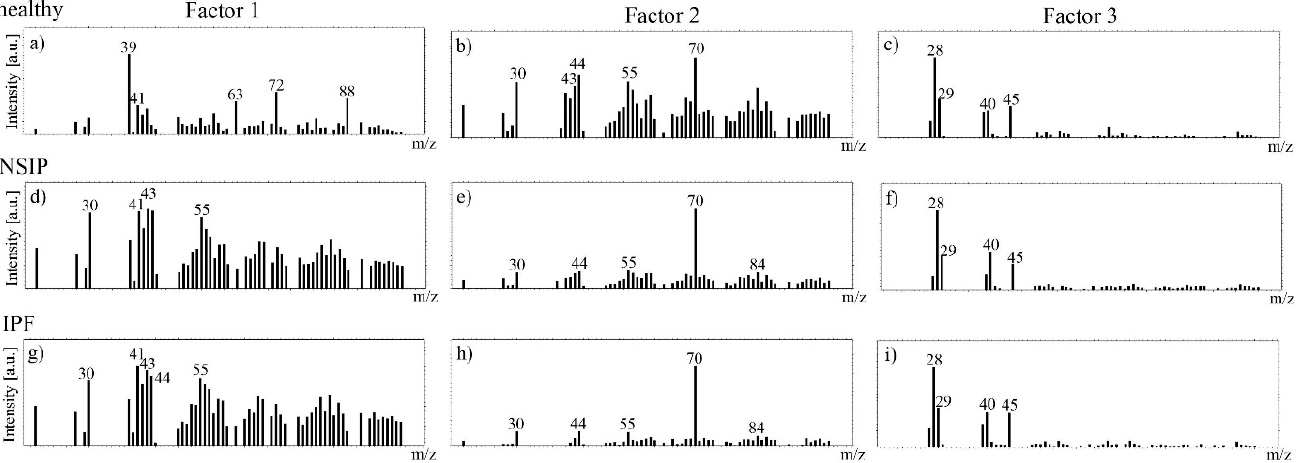
Figure 9. MCR loadings of Factor 1 ( a , d , g ), 2 ( b , e , h ), and 3 ( c , f , i ) spectra determined for healthy ( a – c ), NSIP- ( d – f ), and IPF-derived ( g – i ) fibroblasts.